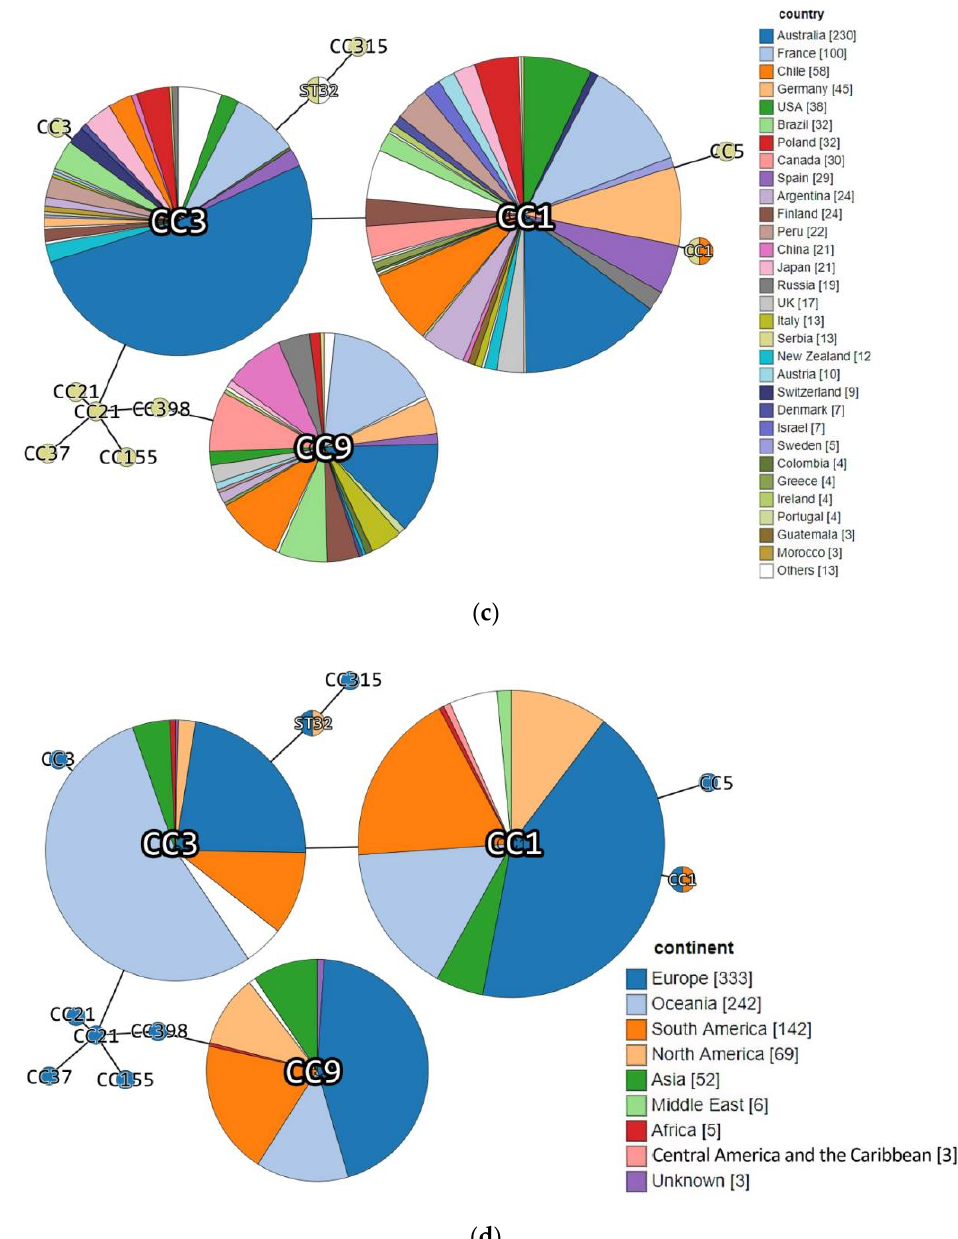
Figure 4. Minimum spanning tree demonstrating genetic relatedness between L. monocytogenes strains isolated in the Republic of Serbia (in 2004 – 2012 and 2019, respectively) and other countries. Each individual circle represents either: ( a , c ) single country or ( b , d ) a certain part of the world. The circle sizes are proportional to the number of strains. Links between circles represent the number of allelic mismatches between either ( a ) individual countries or ( b ) different parts of the world (Supplemental Data 1 ) .